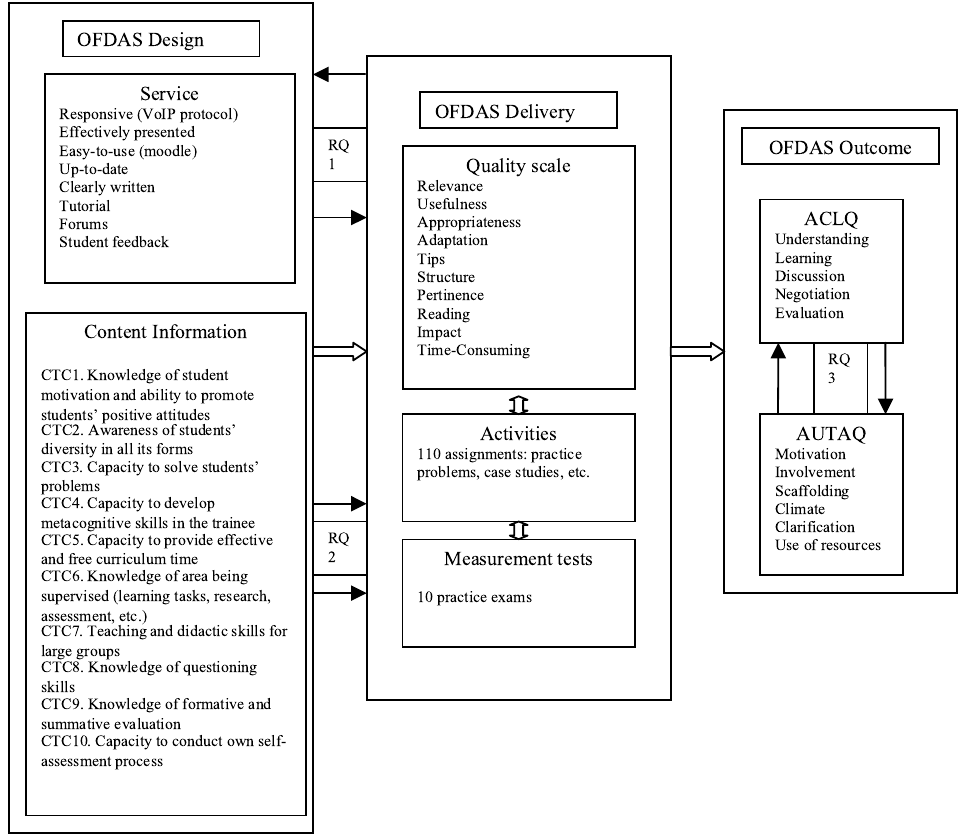
Figure 1. The OFDAS model and sample